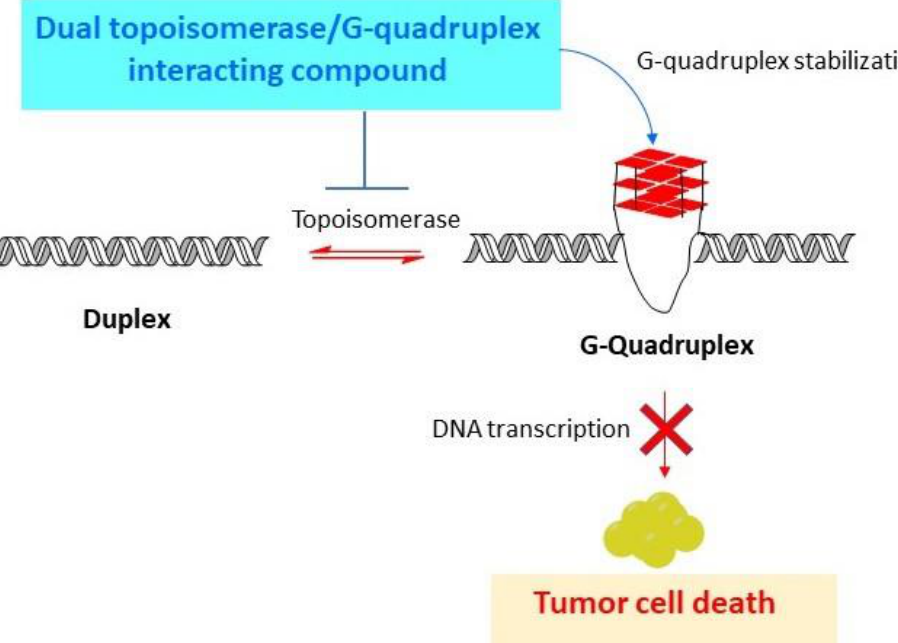
Figure 2. Rationale for developing dual-targeting topoisomerase/G-quadruplex agents in cancer therapy.